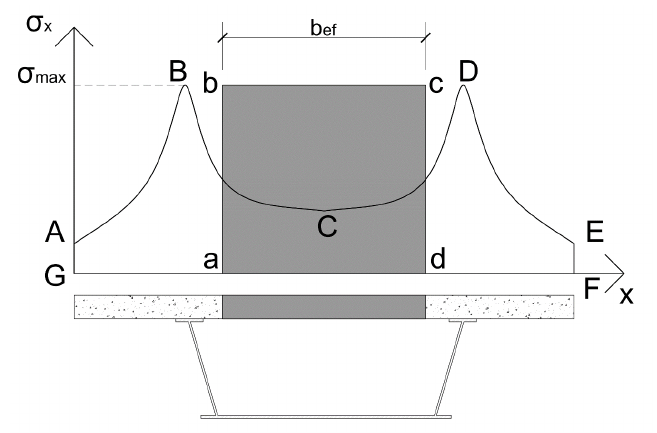
Figure 3. Effective width